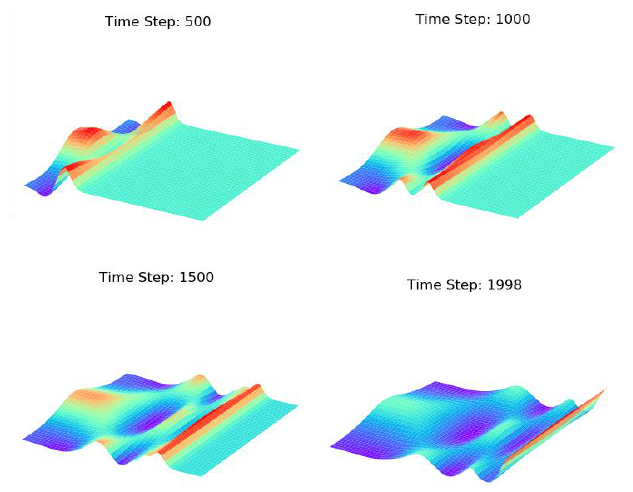
Figure 5. Simulation of water surface elevation at different time steps.